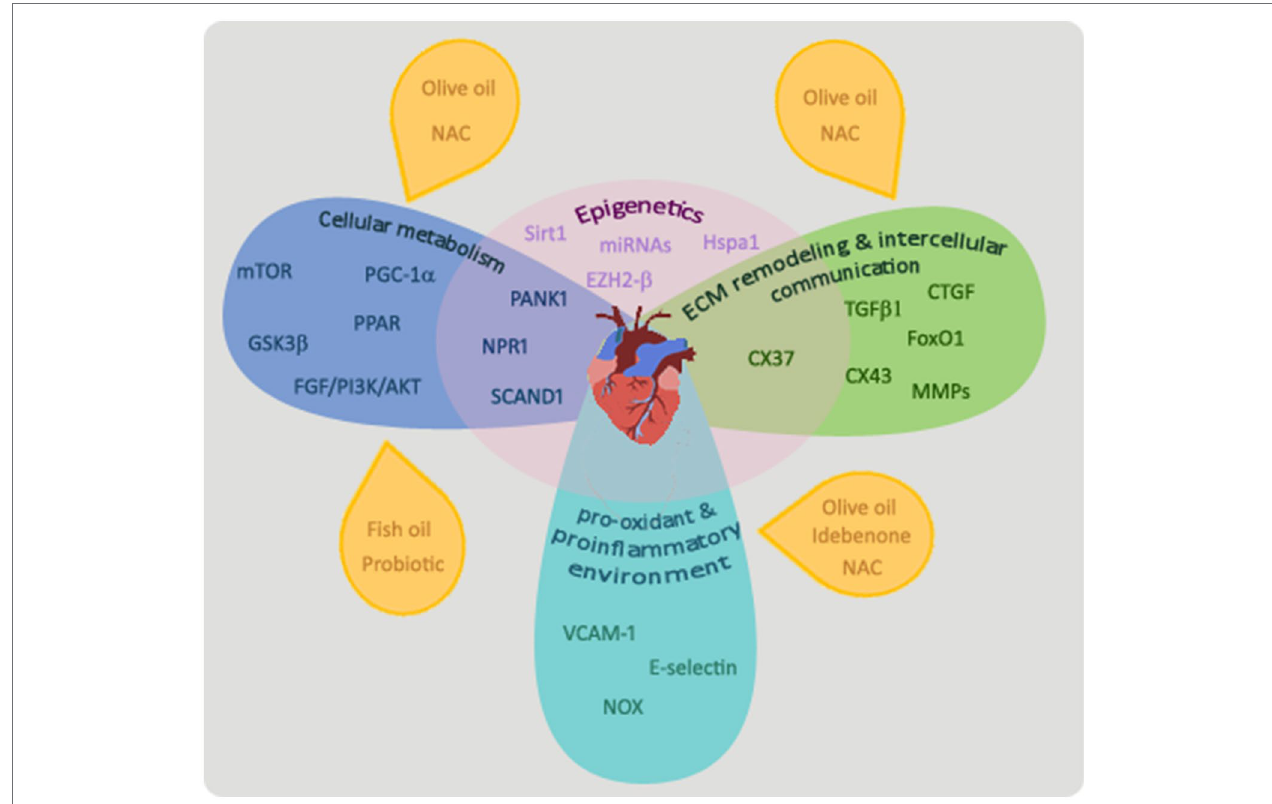
FIGURE 1 | Mechanisms involved in the programming of cardiovascular alterations in offspring by maternal diabetes. Main players that regulate cellular metabolism in the heart of offspring exposed to diabetes in utero are mTOR, PPAR, PANK1, PGC1 α , GDK3 β , NPR1, SCAND1, and the FGF/PI3K/AKT pathway. Maternal treatments with probiotics or a diet enriched in olive or fish oil or N-acetyl-cysteine have been shown to ameliorate cardiac cell metabolism of offspring from diabetic dams. TGF β -1, CTGF, FoxO1, matrix metalloproteinases (MMPs), and connexin 37 (CX37) and 43 (CX43) have been shown to play important roles in the process of ECM remodeling and intercellular communication. A maternal treatment with N-acetyl-cysteine (NAC) or with an olive oil-supplemented diet was able to prevent alterations in the ECM remodeling process observed in the offspring’s heart of animal models of diabetes. An increased pro-oxidant/proinflammatory process and related molecules (VCAM-1, E-selectin, and NOX) have been shown to be involved in the cardiovascular alterations programmed by maternal diabetes. Maternal treatments with an olive oil-supplemented diet or with antioxidants, as idebenone or N-acetyl-cysteine have beneficial effects on this process. All these pathways are interconnected and the underlying mechanism affecting them may be epigenetic